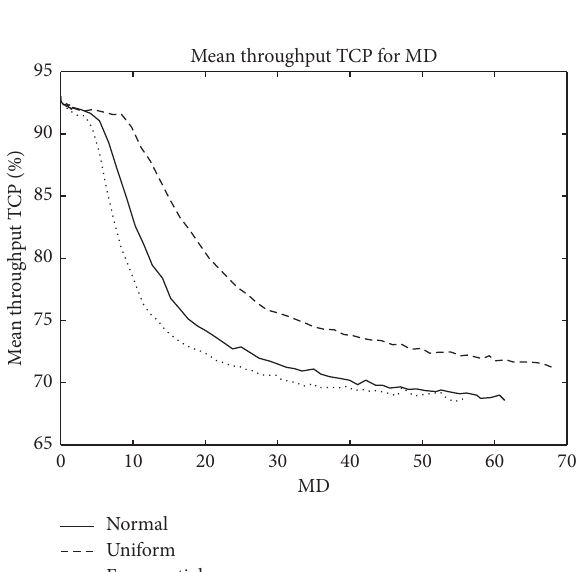
r for diverse jitters .